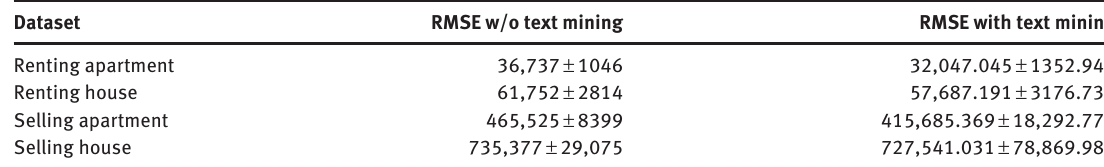
Table 4: Correlation (between Predicted and Actual Price) When LR Was Used in the First Stage of Our Two-Stage Regression Model. Dataset